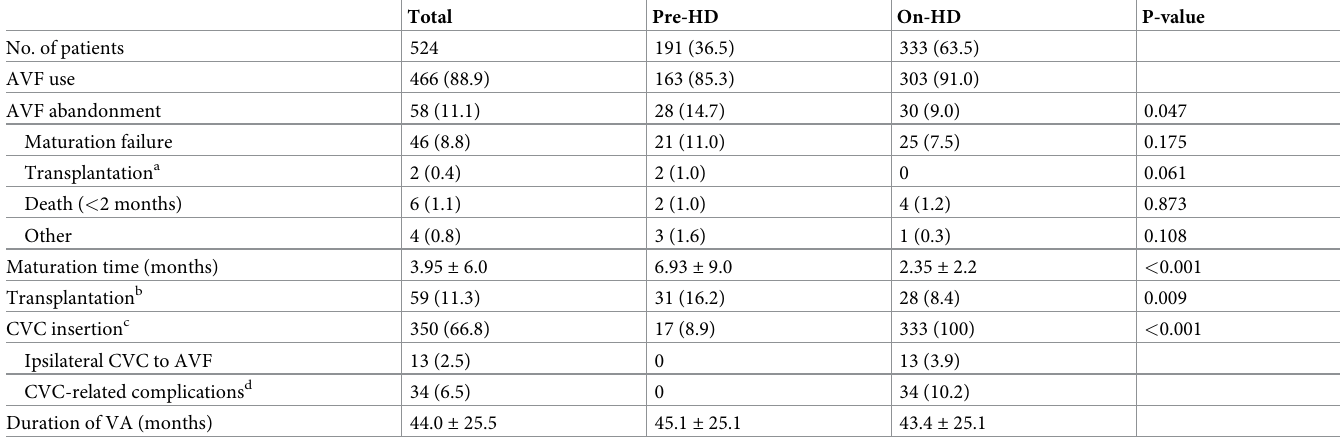
Table 5. Other clinical outcomes of the study patients.